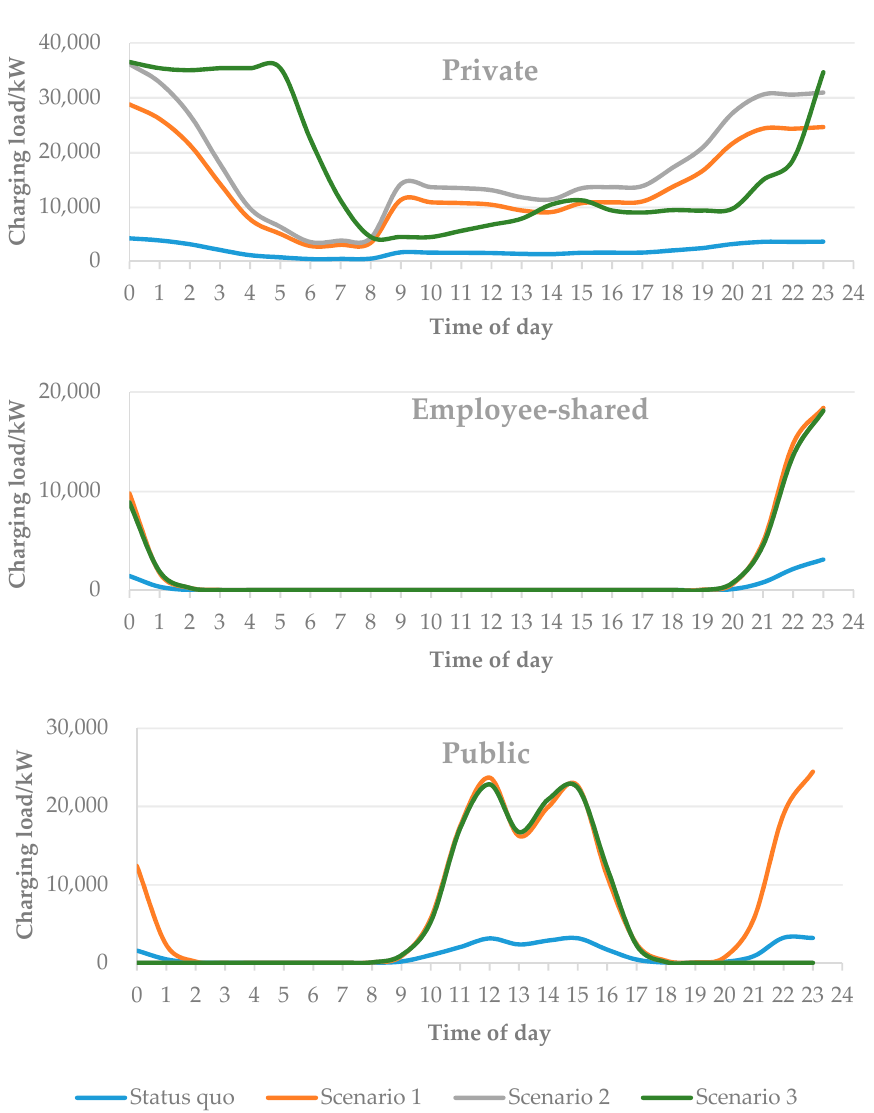
Figure 7. Temporal distribution of charging loads of each pile in different scenarios.